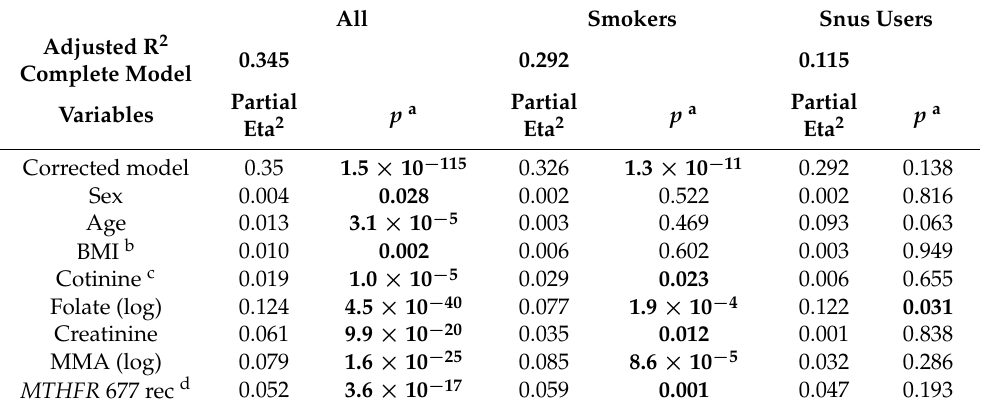
Table 3. Main effects multiple regression models on possible determinants of tHcy (log).